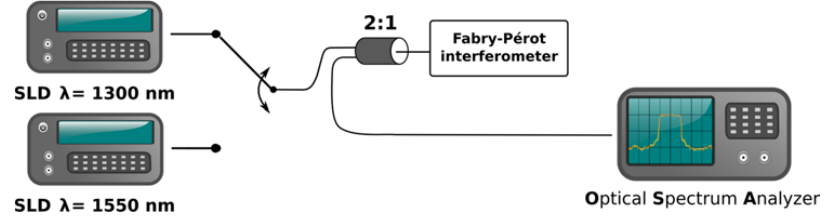
Figure 3. Measurements setup for fiber-optic Fabry-Pérot interferometer in reflection mode. Two broadband sources based on superluminescent diodes, S1300-G-I-20 and S1550-G-I-10 (Superlum Ltd., Carrigtohill, Ireland) were used in the setup. Their central wavelengths were 1288 nm and 1562 nm, respectively. Spectral width of both sources, measured as full width at half maximum (FWHM), was about 50 nm, as shown in Figure 4.